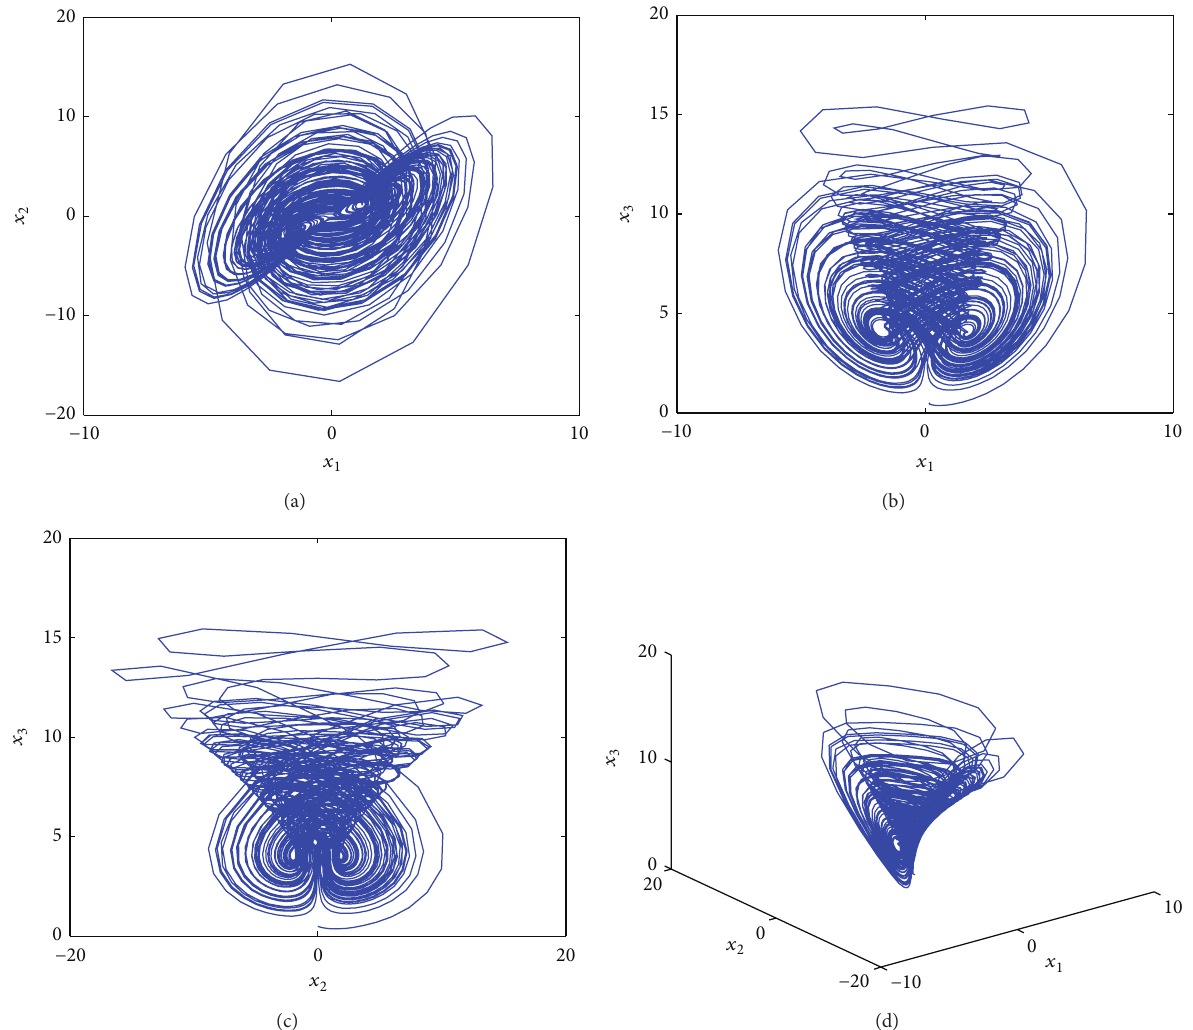
Figure 7: Chaotic attractors in the fractional order Liu system with 𝛼 = 1.05 . The panels (a), (b), (c), and (d) show the 𝑥 2 −𝑥 1 , 𝑥 3 −𝑥 1 , 𝑥 3 −𝑥 2 , and 3D views,